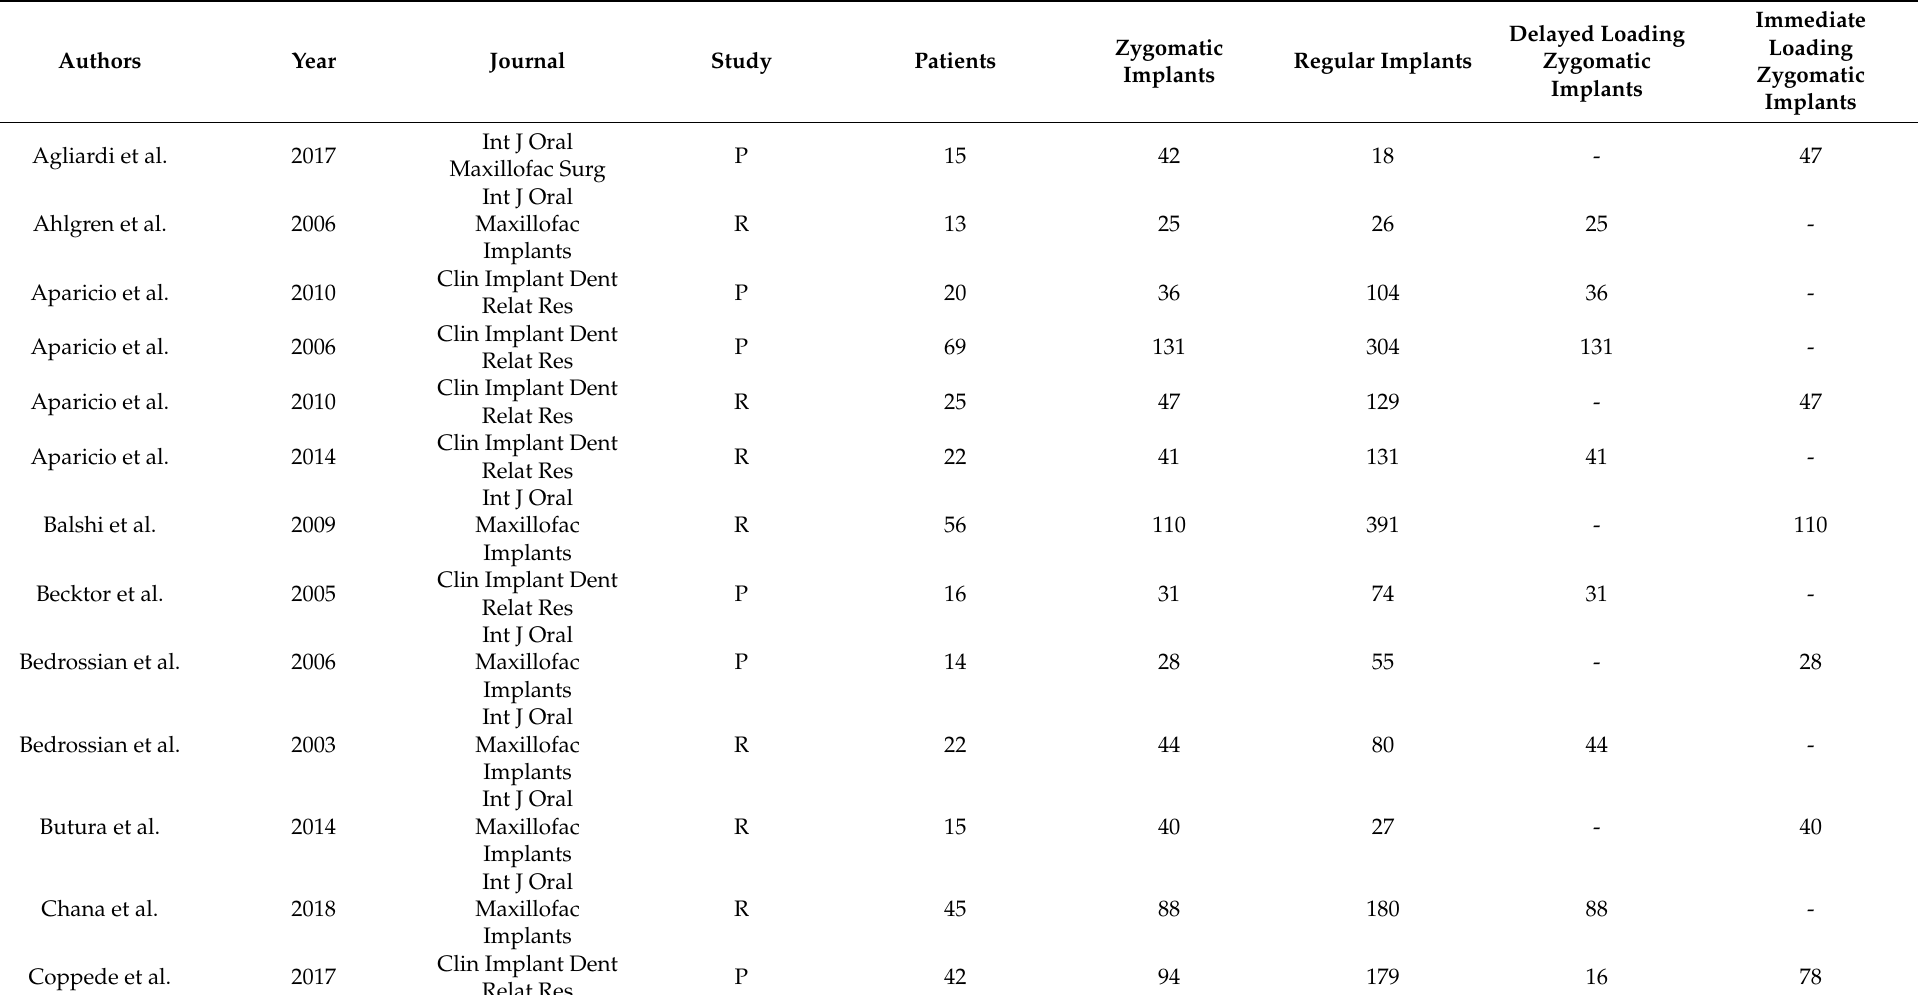
Table 4. Summary of the papers evaluated according to the study design, patients treated, zygomatic and regular screws positioned and implant loading